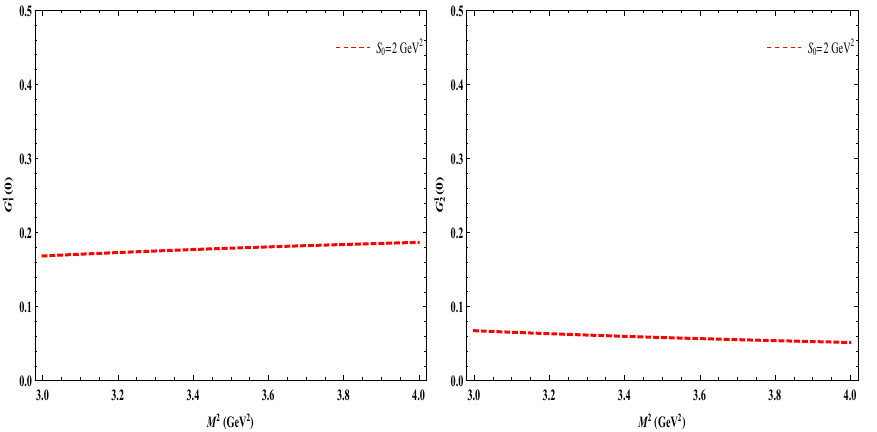
Figure 1. The dependency of the decay form factors G 1 different Borel mass parameters M 2 .